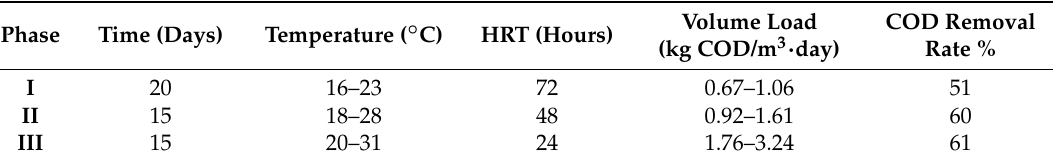
Table 3. Operational conditions during ABR